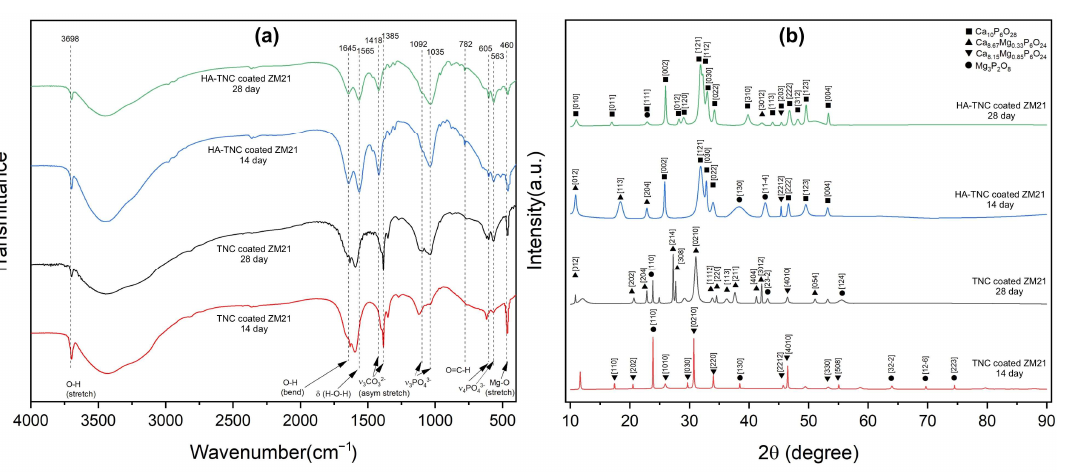
Figure 11. ( a ) FTIR spectrums and ( b ) XRD patterns of apatite mineralized on HA-TNC-coated ZM21, ZM21, and TNC-coated ZM21 samples after 14 and 28 days of SBF immersion.